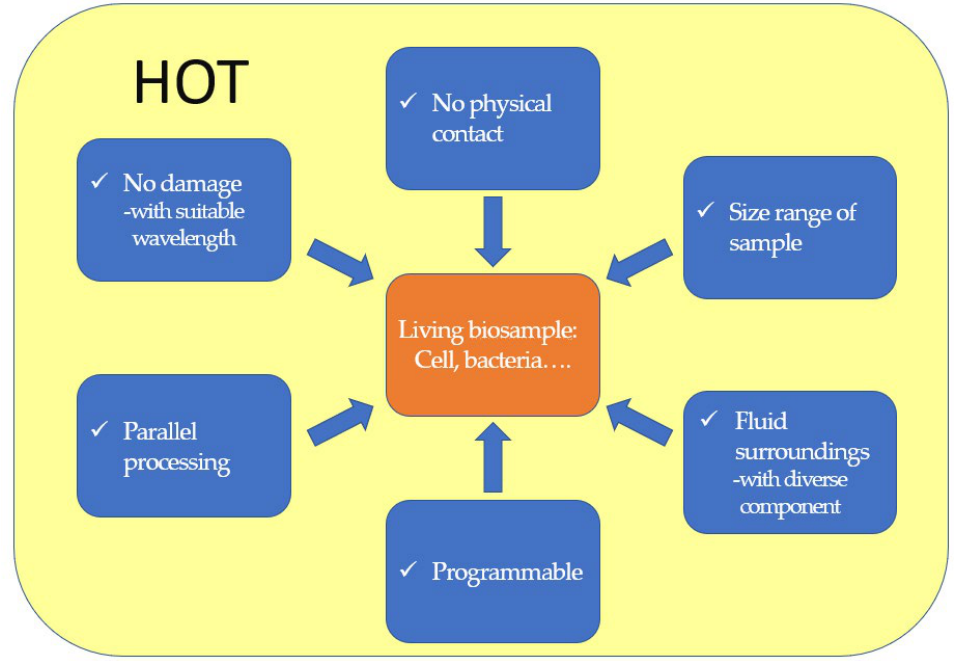
Figure 5. The advantages and characteristics of HOT in bio-applications.